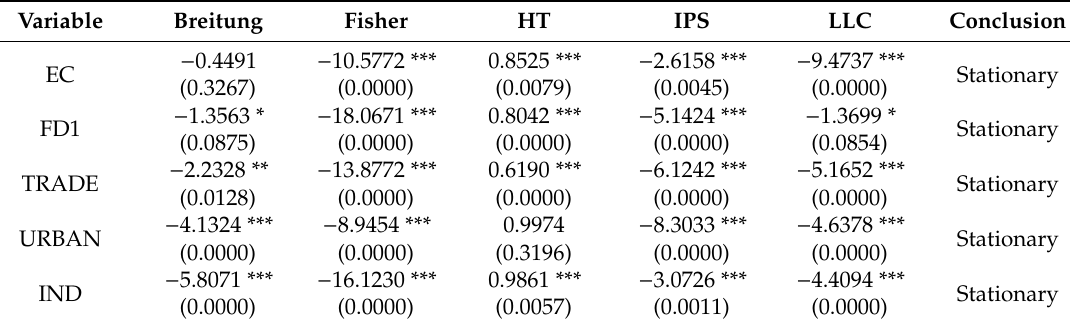
Table 4. Results of panel unit root tests.